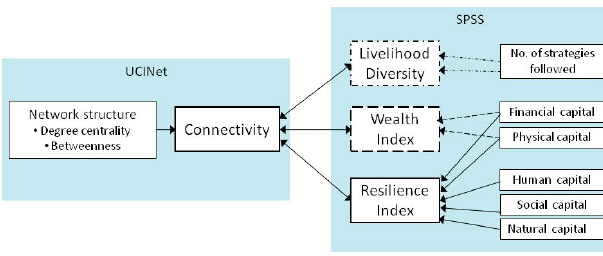
Fig. 4 . Schematic diagram showing the analytical approach used to assess the relationship between connectivity and different measures of